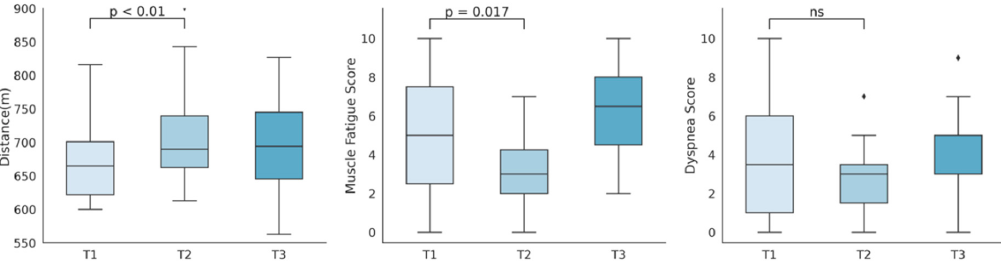
Figure2. Representationofsix-minutewalkingtestdistancetravelled, musclefatiguescore, Figure 2. Representation of six-minute walking test distance travelled, muscle fatigue score, and dyspnea score, measured before (T1), immediately after (T2), and six months after the program (T3).